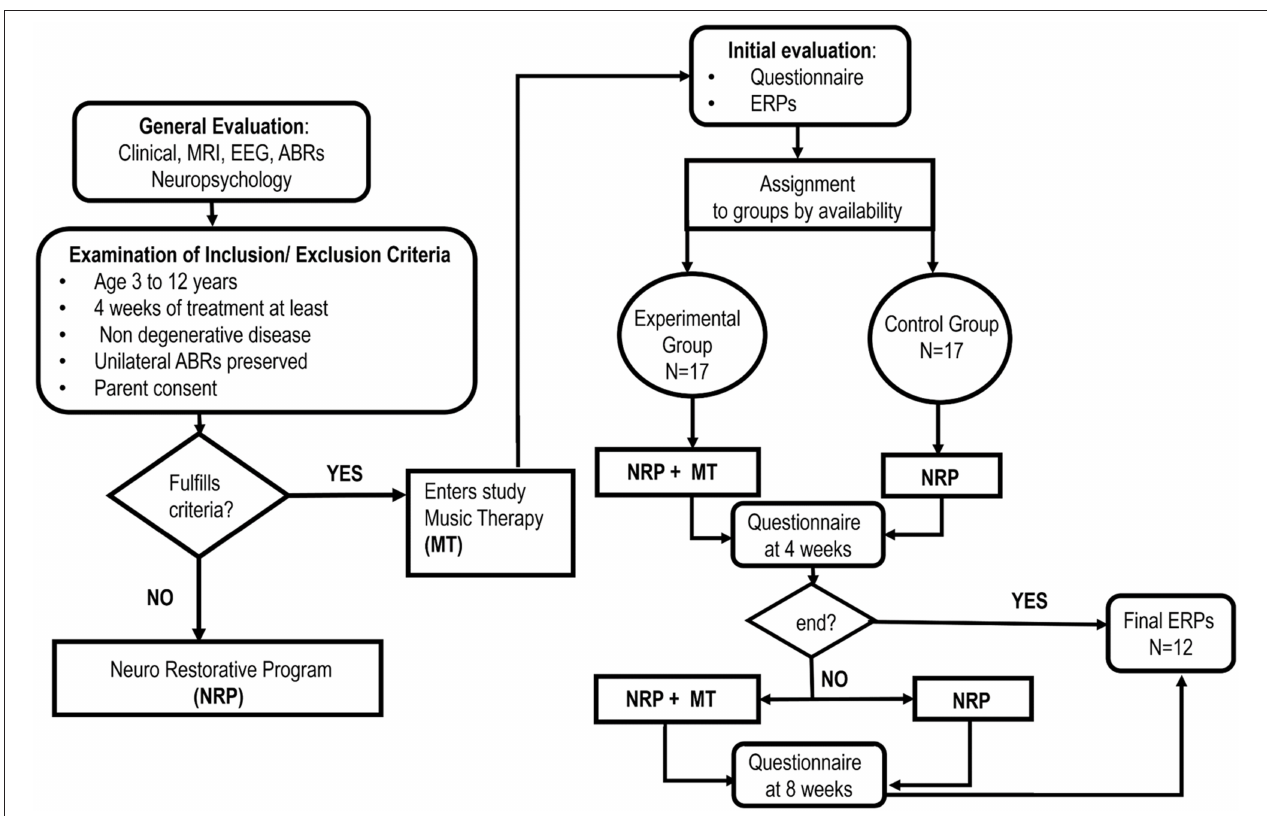
FIGURE 1 | Study flow